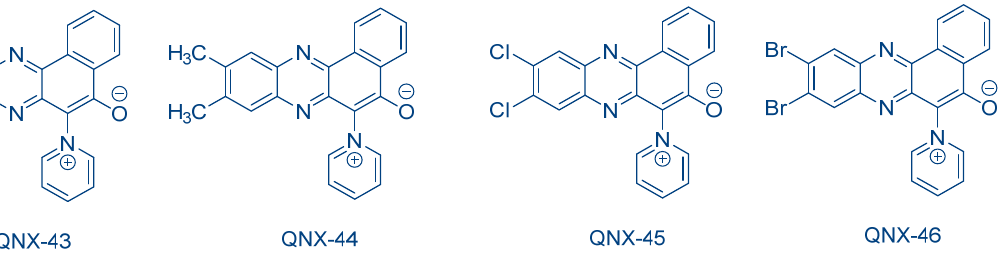
Figure 37. Chemical structures of 6-pyridinium benzo[a]phenazine-5-oxide derivatives QNX-43-QNX-46.